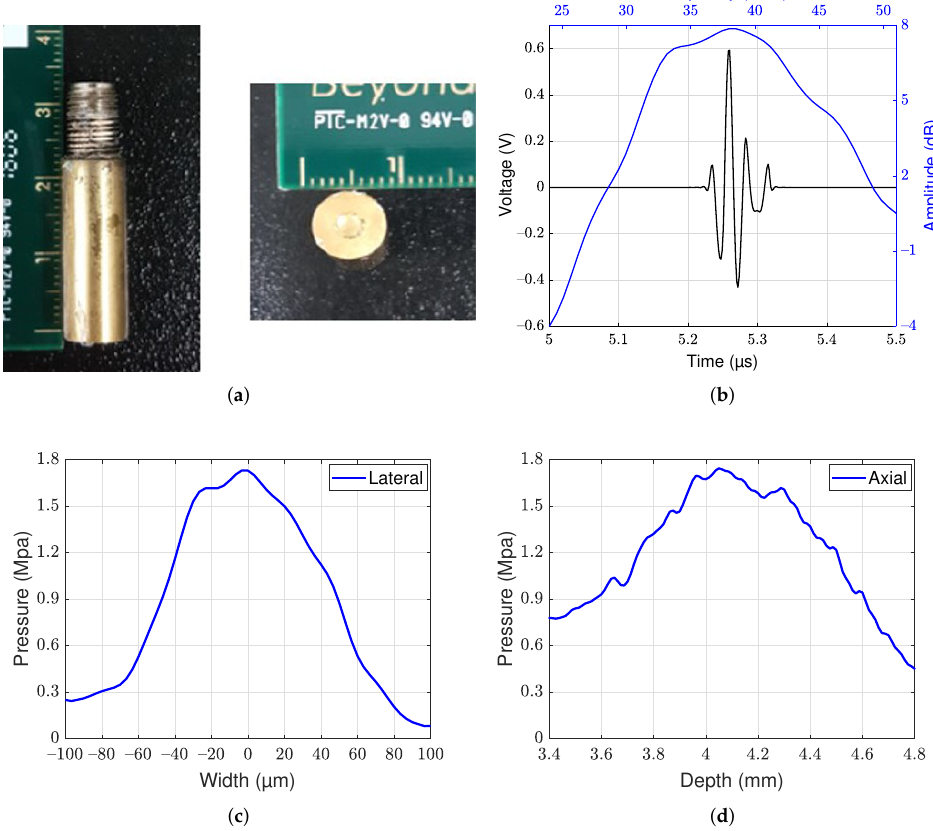
Figure 2. Characteristics of the 38 MHz lithium niobate ultrasound transducer at the focus of ultrasound beam. ( a ) Photographic image of the transducer, ( b ) pulse-echo characteristics of the transducer, ( c ) lateral beam profile, and ( d ) axial beam